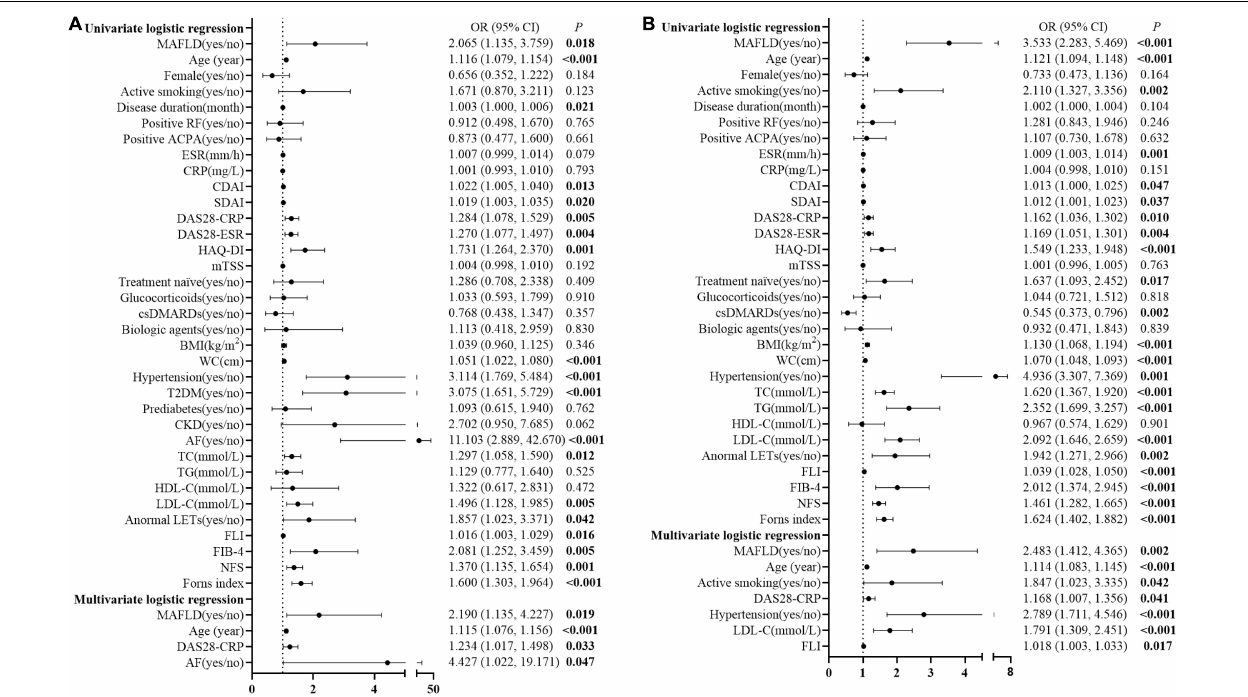
FIGURE 2 | Logistic regression analysis for potential associated factors of CVD events and high estimated 10-year CVD risk in patients with RA. Forest plots show OR and 95% CI for CVD events (A) and high estimated 10-year CVD risk (B) in patients with RA. MAFLD, metabolic dysfunction-associated fatty liver disease; RF, rheumatoid factor; ACPA, anti-cyclic citrullinated peptide antibody; ESR, erythrocyte sedimentation rate; CRP, C-reactive protein; CDAI, clinical disease activity index; SDAI, simplified disease activity index; DAS28-CRP, disease activity score in 28 joints with four variables, including CRP; DAS28-ESR, disease activity score in 28 joints with four variables including ESR; HAQ-DI, health assessment questionnaire disability index; mTSS, modified total Sharp score; csDMARD, conventional synthetic disease-modifying anti-rheumatic drug; BMI, body mass index; WC, waist circumference; T2DM, type 2 diabetes mellitus; TC, total cholesterol; TG, triglyceride; HDL-C, high-density lipoprotein cholesterol; LDL-C, low-density lipoprotein cholesterol; LFTs, liver function tests; FLI, fatty liver index; FIB-4, fibrosis-4 index; NFS, NAFLD fibrosis score; OR, odds ratio; CI, confidence interval.